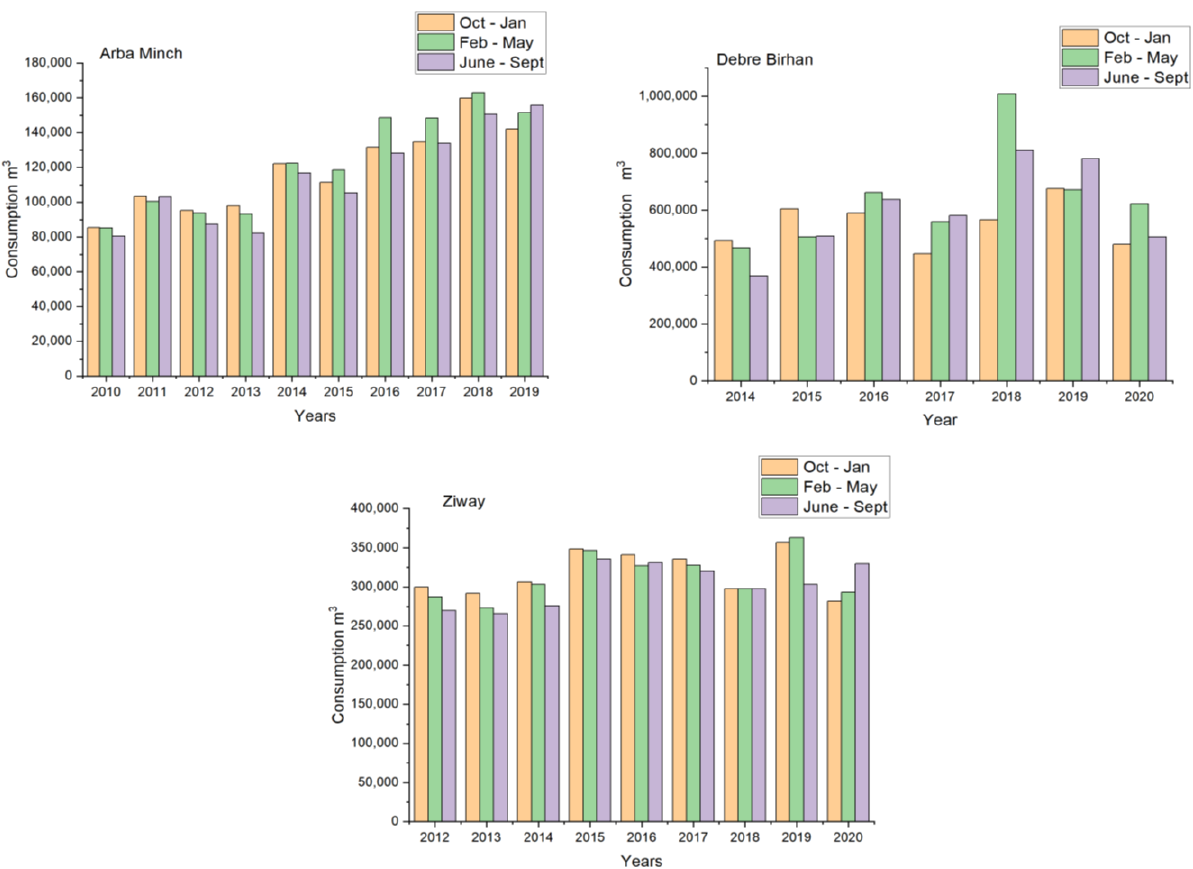
Figure 2. The maximum water consumption, seasonal based component occurs in March and a minimum in August.